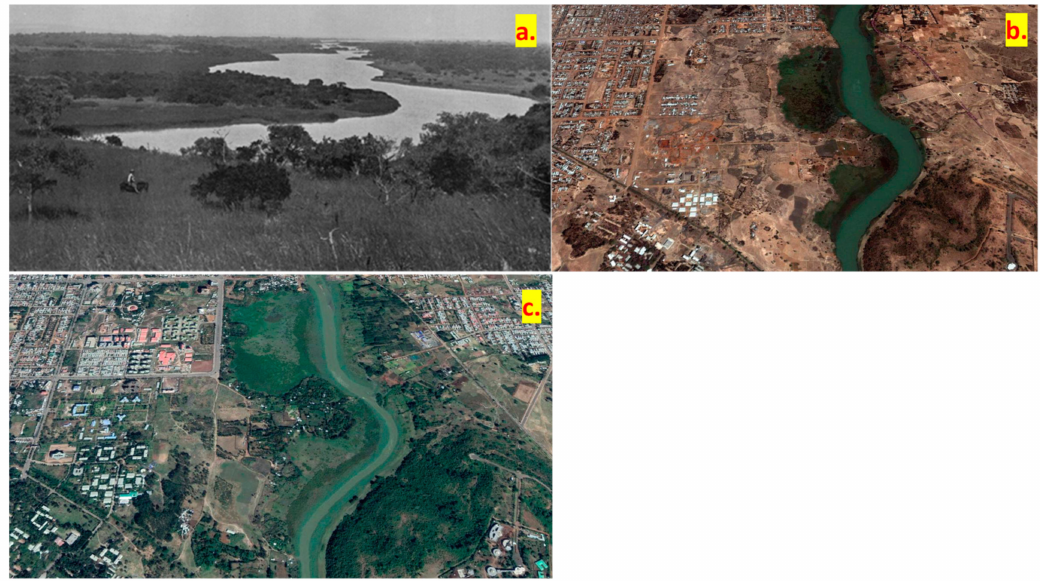
Figure 2. “The Blue Nile channel leading from the outlets of Lake Tana” (looking to the South), as seen in 1920 (Grabham and Black, 1925) ( a ), Google Earth map of the area taken in 2005 ( b ), and Google Earth map of the area taken in 2020 ( c ). A significant amount of the previous watercourse in ( c ) is exposed, portraying the water flowing out of Lake Tana is reduced due to water transfer to the Beles basin since